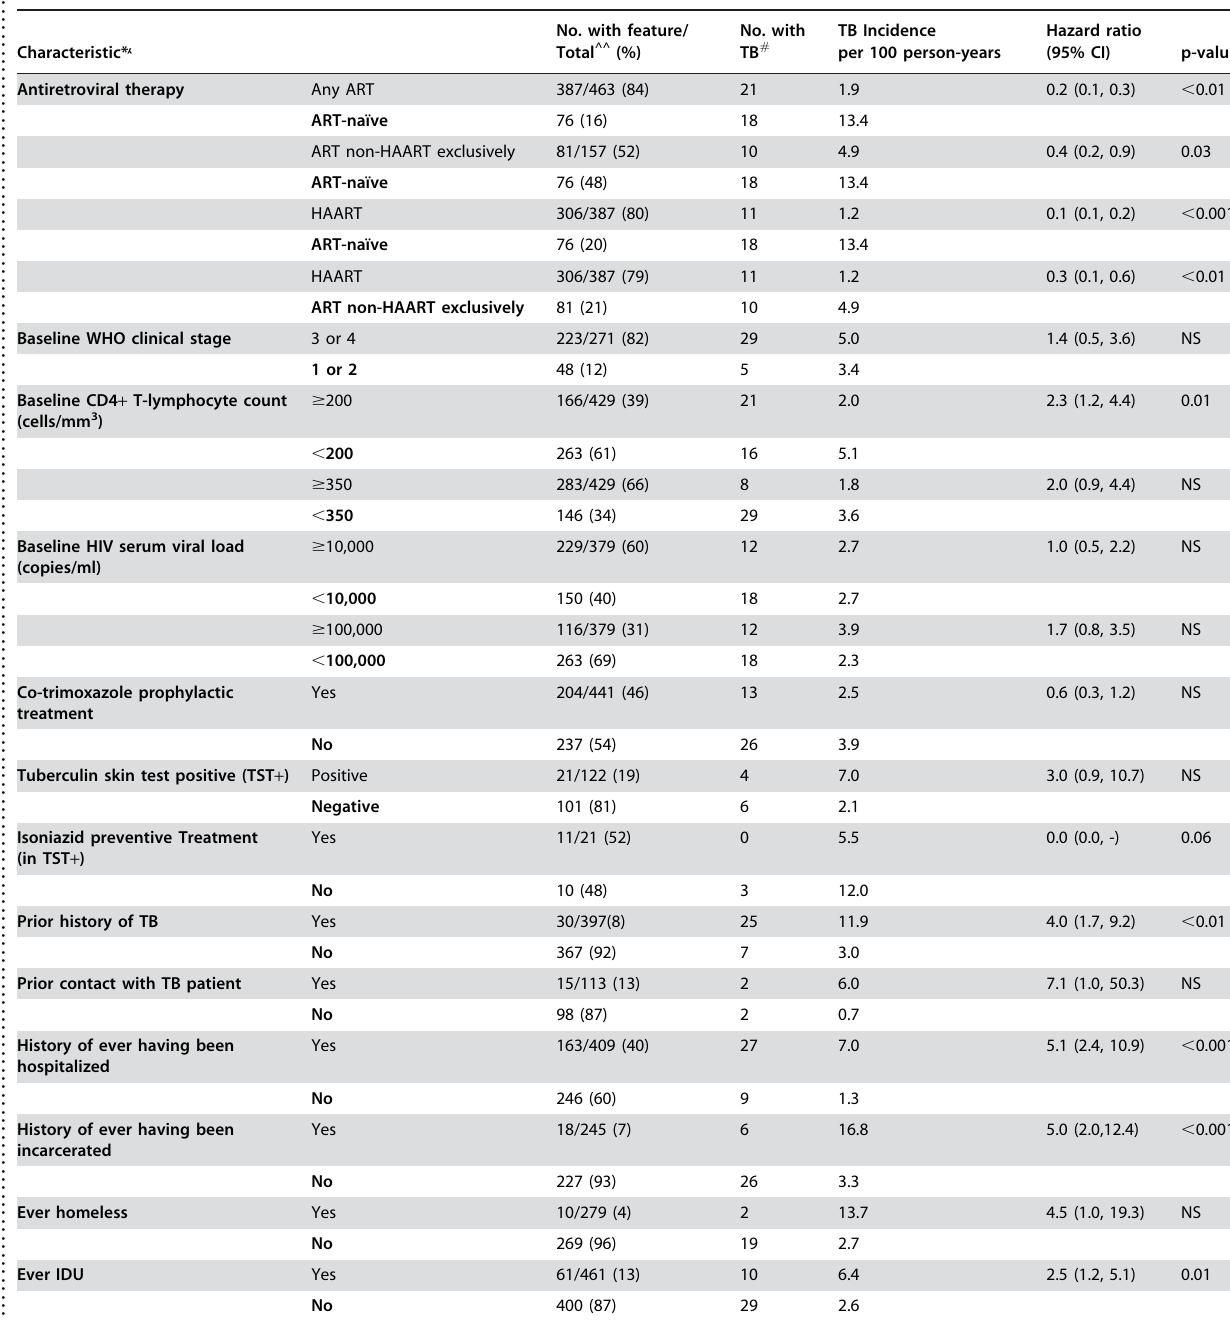
No. with No. with feature/ TB # Total ^^ (%)